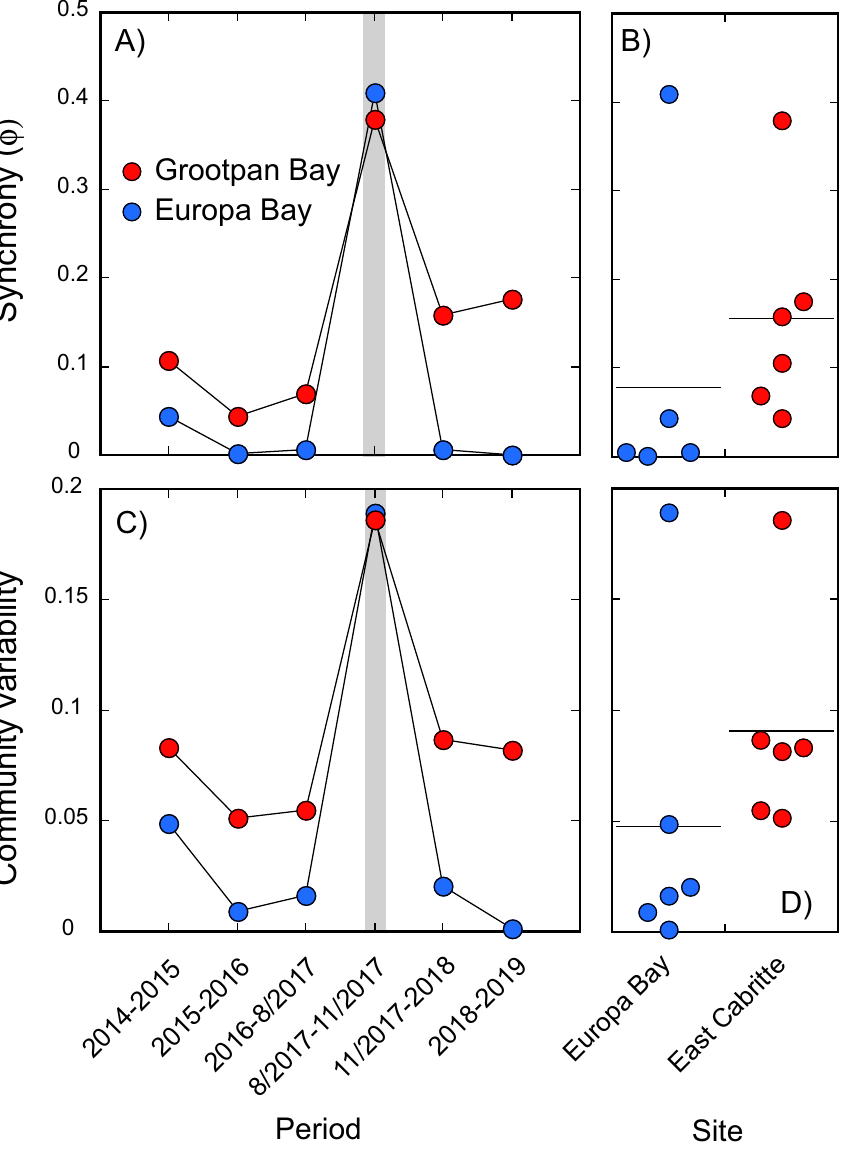
c n ) ( C , D ) (after Thibaut and Connolly 2013) for c n over time, with Hurricanes Irma and Maria shown with the grey c n